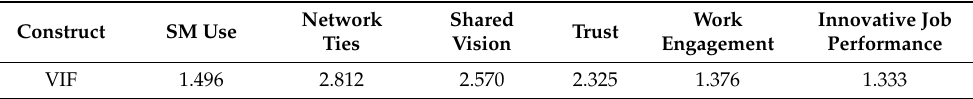
Table 3. Full Collinearity test.